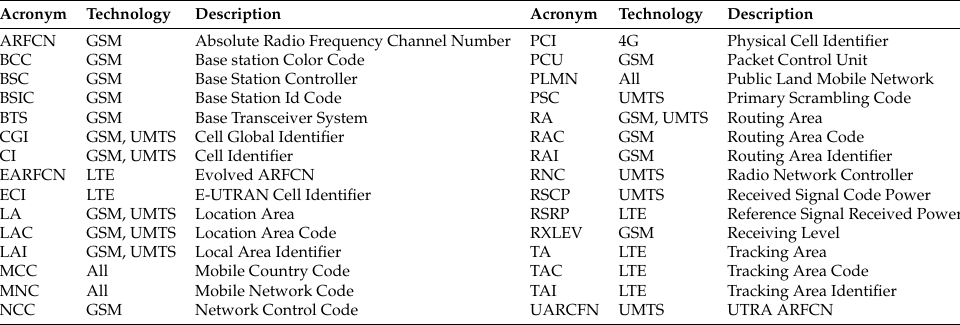
Table 1. Acronyms related to the specific network technologies used throughout the paper.